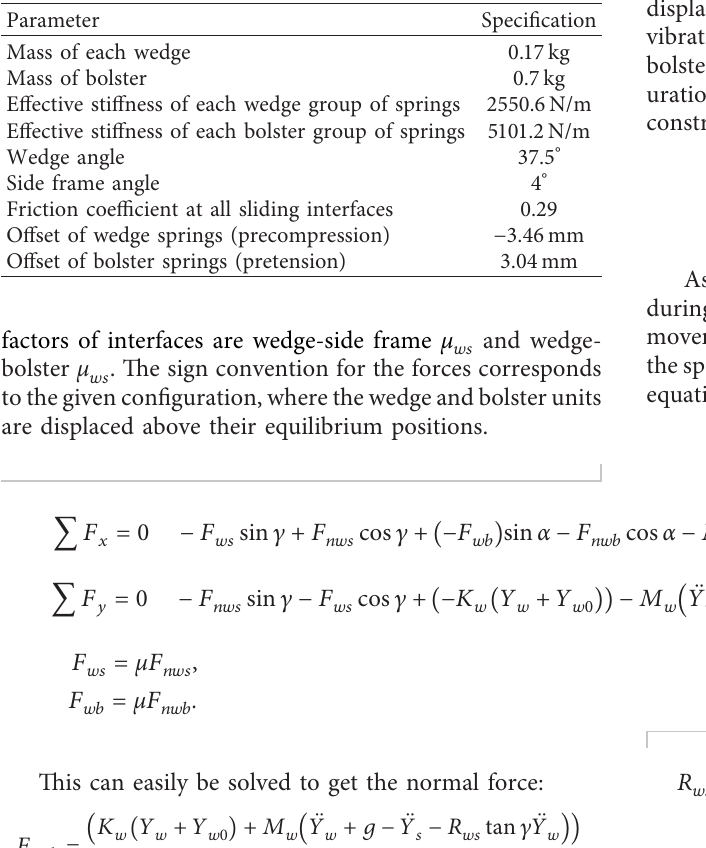
Figure 4: Variable damping suspension. Table 1: Specification of the suspension